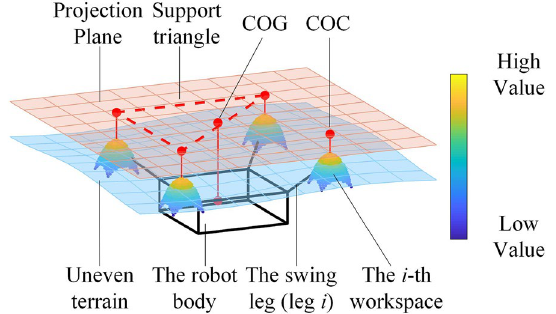
Figure 5 Magnitudes employed to characterize the motion continuity of quadruped robot by using Inverted